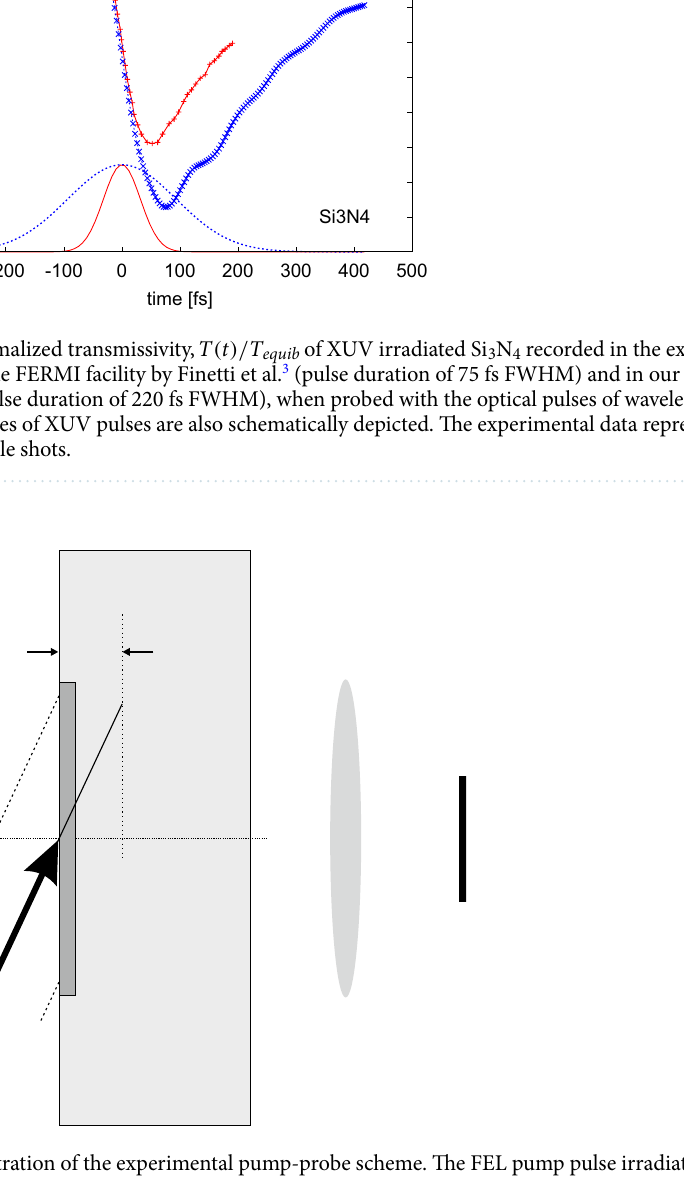
Figure 2. Illustration of the experimental pump-probe scheme. The FEL pump pulse irradiates the tilted sample (light grey box of thickness d ) at a grazing angle. The extended size of the FEL focus is indicated by the dashed inclined lines. This also sets the temporal window (see, e.g., 3 ). The transmission of the optical pulse is observed by an imaging system (here indicated by a schematic lens and a black box as the detector). The relevant area, where the transmission is observed, is restricted to the FEL-pulse irradiated region. The penetration depth of the FEL pulse is indicated by arrows. For comparison, the thickness of the dark grey box indicates the range of the released